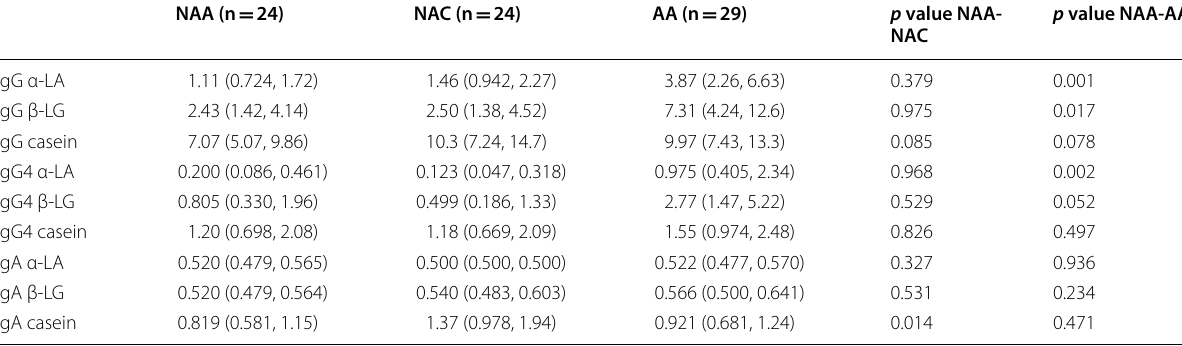
α-LA α-lactalbumin, β-LG β-lactoglobulin. Geometric mean (95% CI) = = Table 3 Correlations (rho) between MMP-1 and different inflammatory markers in the included study groups